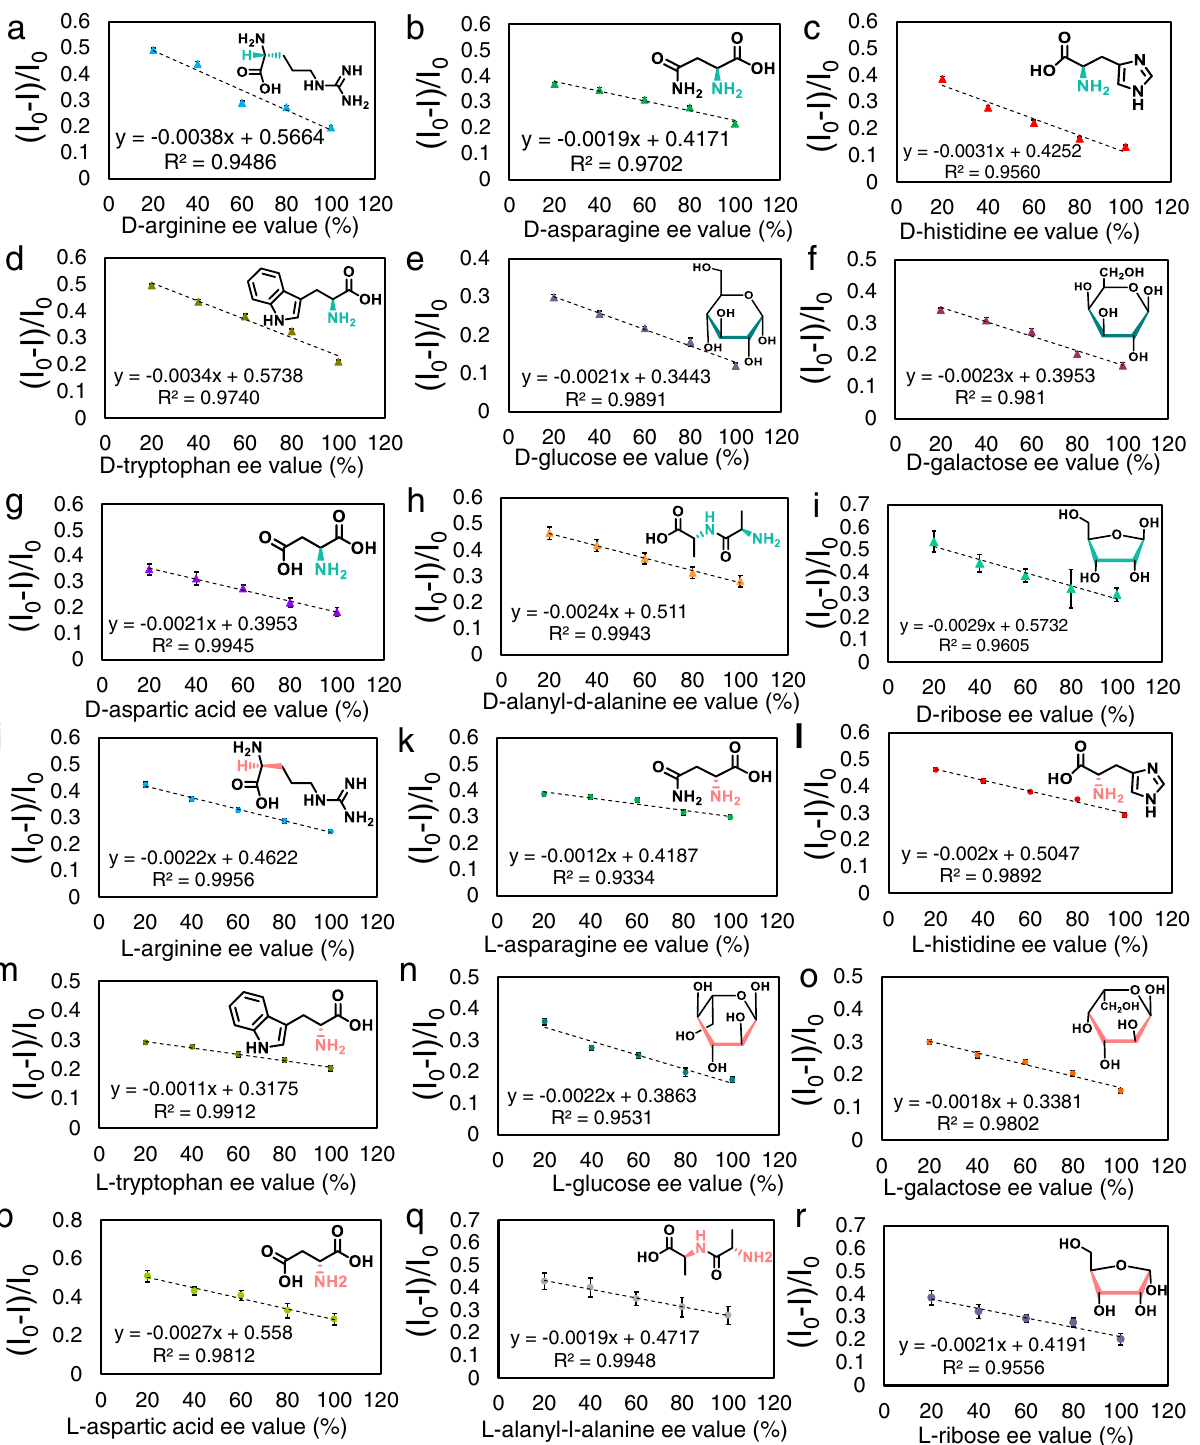
Fig. 7 | Chiral discrimination by the SERS-CIPs based on IRM. a – h , and i Linear relationship between the relative SERS intensity (( I 0 − I )/ I 0 ) and D -enantiomers in racemic mixtures with different ee % values after recognition with SERS- D -IP. j – q , and r Linear relationship between the relative SERS intensity (( I 0 − I )/ I 0 ) and L - enantiomersintheracemicmixtureafterrecognitionwithSERS- L -IP. I 0 and I arethe